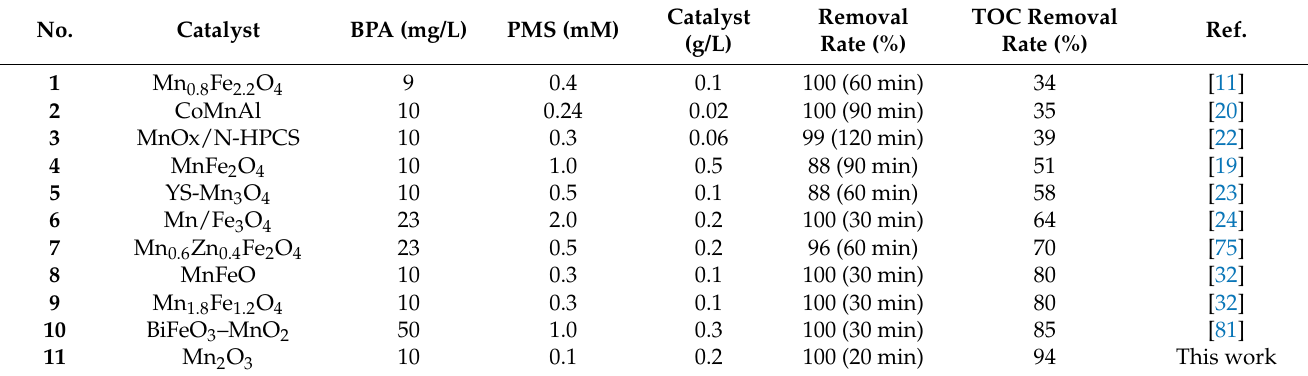
Table 1. Comparison of catalytic performances of Mn 2 O 3 and lab-made catalysts reported in